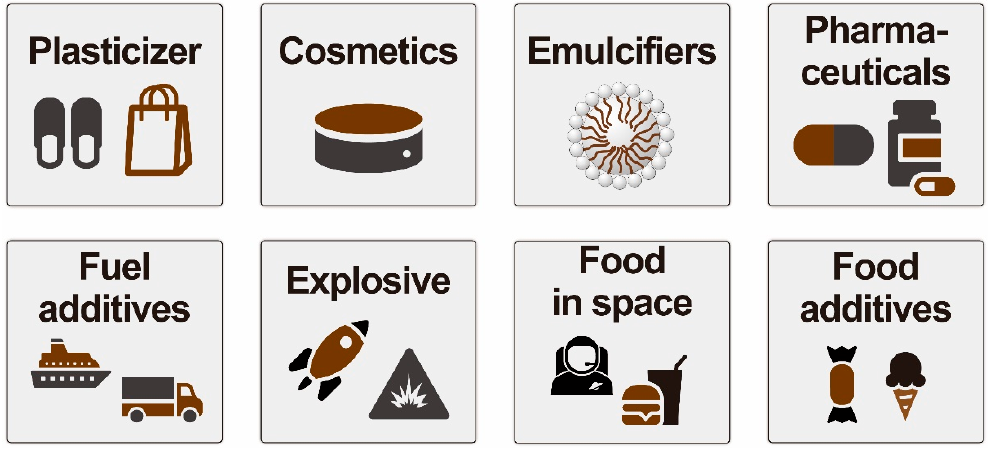
Figure 2. Common uses of